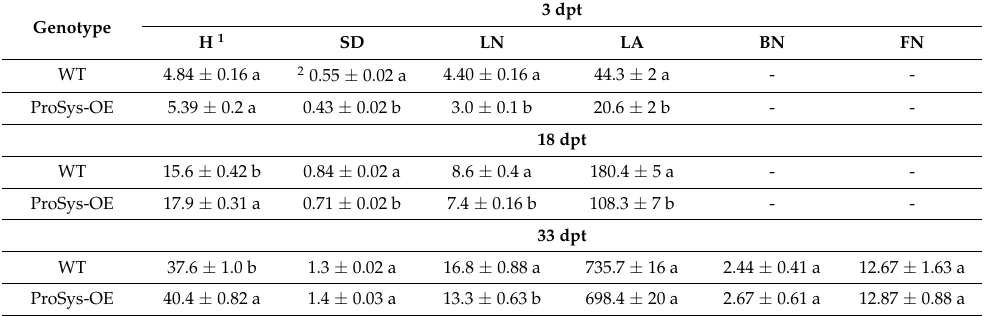
Table 1. Vegetative and reproductive growth parameters in wild-type (WT) and prosystemin over- expressing (ProSys OE) tomato plants. Six plant development- and reproductive-related attributes were measured in WT untransformed tomato plants and in ProSys-OE plants overexpressing the ProSys precursor protein of the systemin peptide hormone. Parameter quantification was performed in plants at 3, 18 and 33 days post-transplantation (dpt) of seedlings to 5 L plant pots. 3 dpt Genotype H 1 SD LN LA